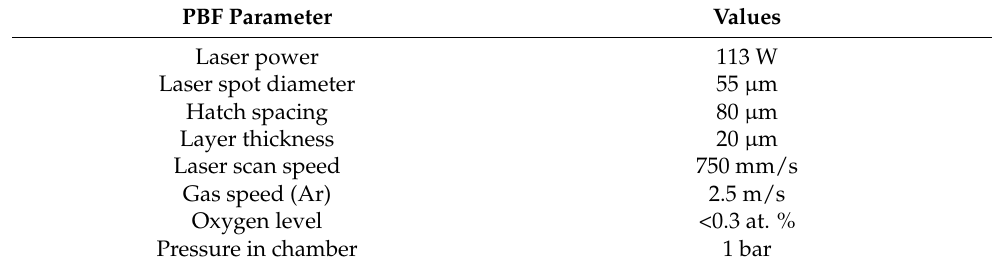
Table 1. Build parameters.